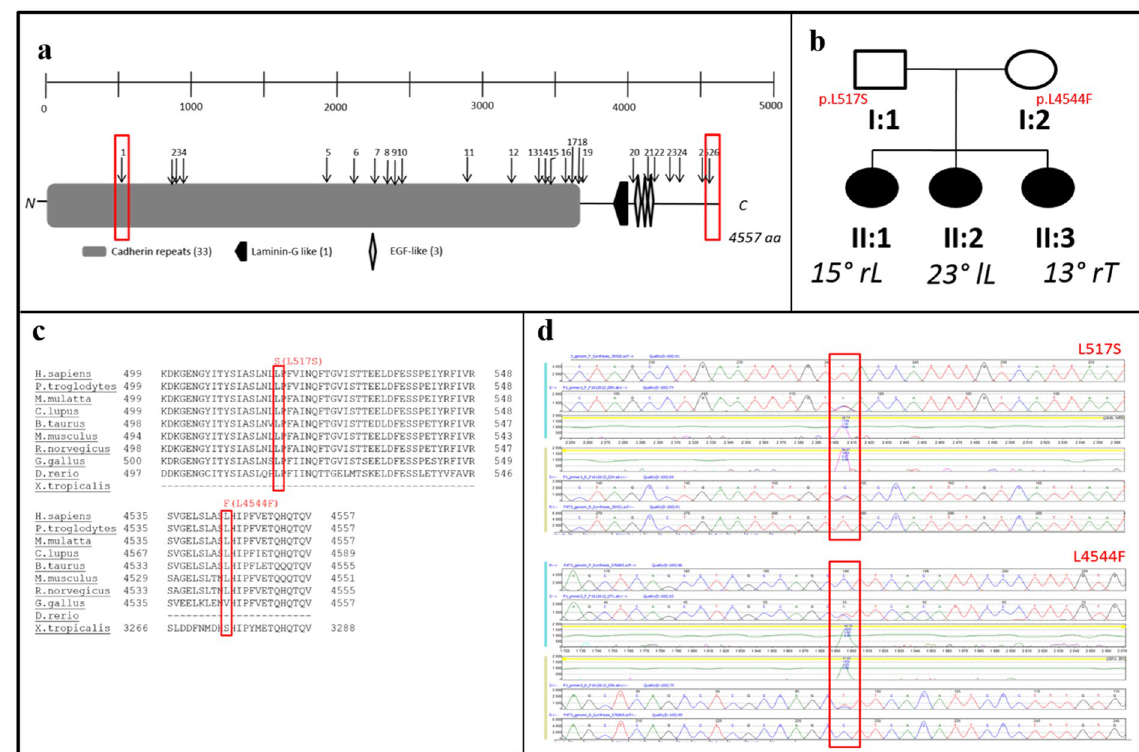
Figure 1. Multiplex AIS family. One family in our cohort (ID1581) consisted of three affected sisters and two unaffected parents. ( a ) FAT3 protein organization as annotated by NCBI is 4557 amino acids long and includes multiple functional homology domains. The positions of the 26 rare variants identified in our study among the AIS cases are labelled from 1 to 26 and are indicated by vertical arrows above the protein schema. The location of two heterozygous mutations present in this multiplex AIS family are indicated by the red boxes. ( b ) A simplified pedigree and segregation of the FAT3 mutations. ( c ) A sequence alignment with different species showing that both mutations affect an invariantly conserved amino acid sequences in FAT3 orthologues. ( d ) Sequence chromatograms showing those heterozygous